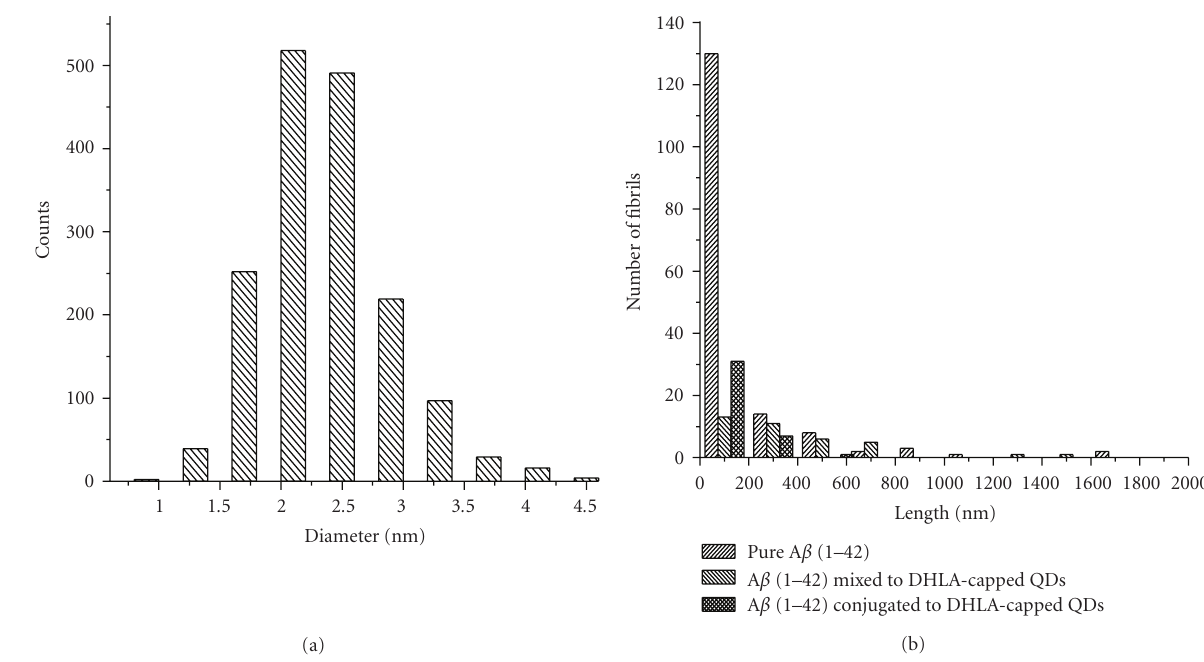
Figure 5: (a) Histogram for the size distribution of DHLA-capped CdSe/ZnS QDs; (b) statistical analysis of number of fibrils versus length of fibrils for three di ff erent samples containing A β (1–42) mixed to DHLA-capped QDs, A β (1–42) conjugated to DHLA-capped QDs, and pure A β